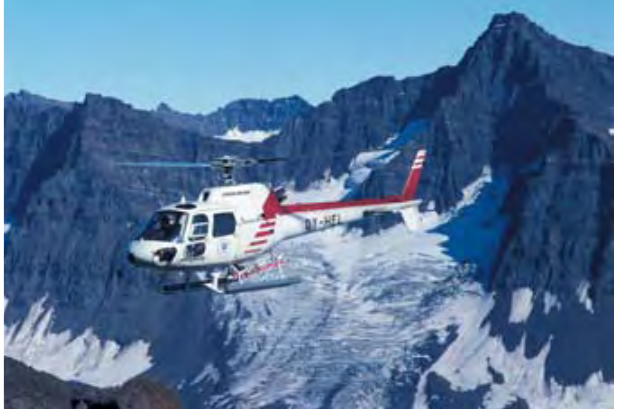
Figure 12. Early Tertiary flood basalt sequence in eastern Greenland associated with rifting and breakup between eastern Greenland and northwestern Europe, highlighting opportunities along some margins for synergetic onshore-offshore studies.